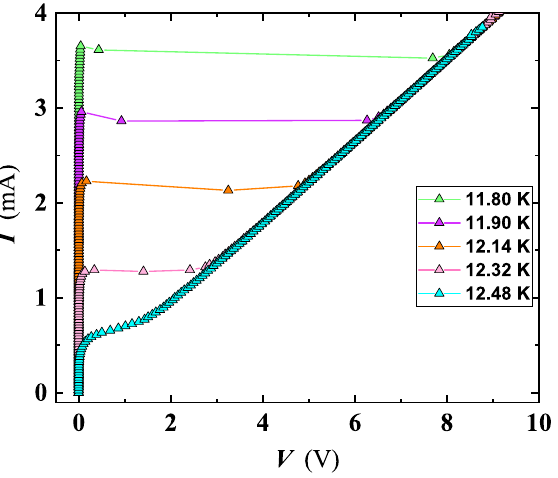
Figure 3. I-V curves of the film SC15, measured at several T close to the SC transition of T c = 12.73 K. Approaching T c , the amplitude of the hysteresis between the sweep-up and sweep-down of the current narrows.